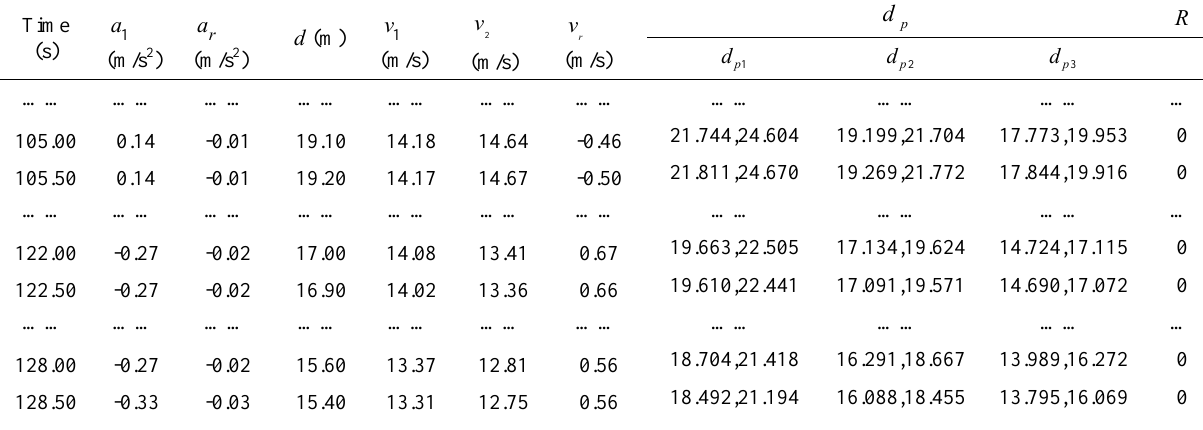
Table 9. Model validation Part of the